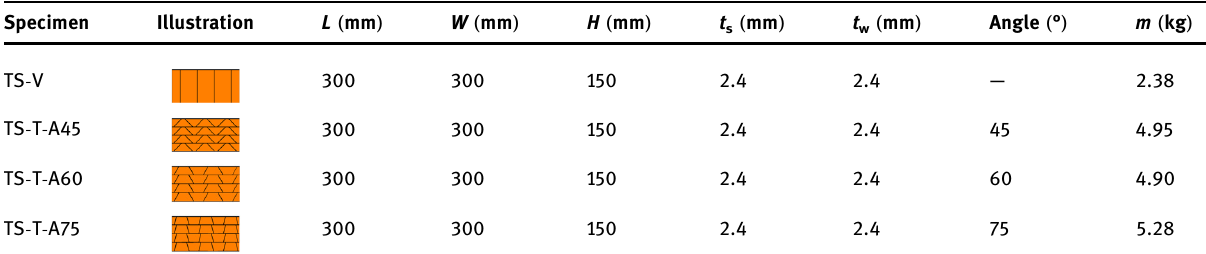
Table 1: Dimension parameter of specimens Specimen Illustration